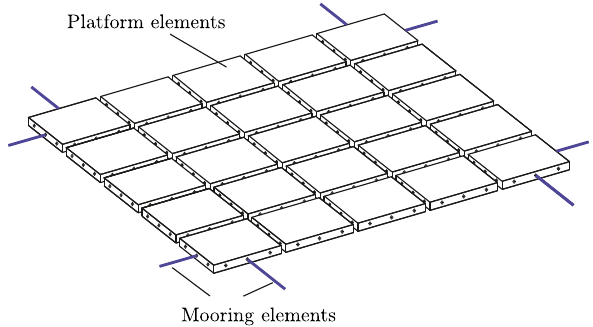
Figure 1. Example of a floating platform arrangement with mooring lines on the corner